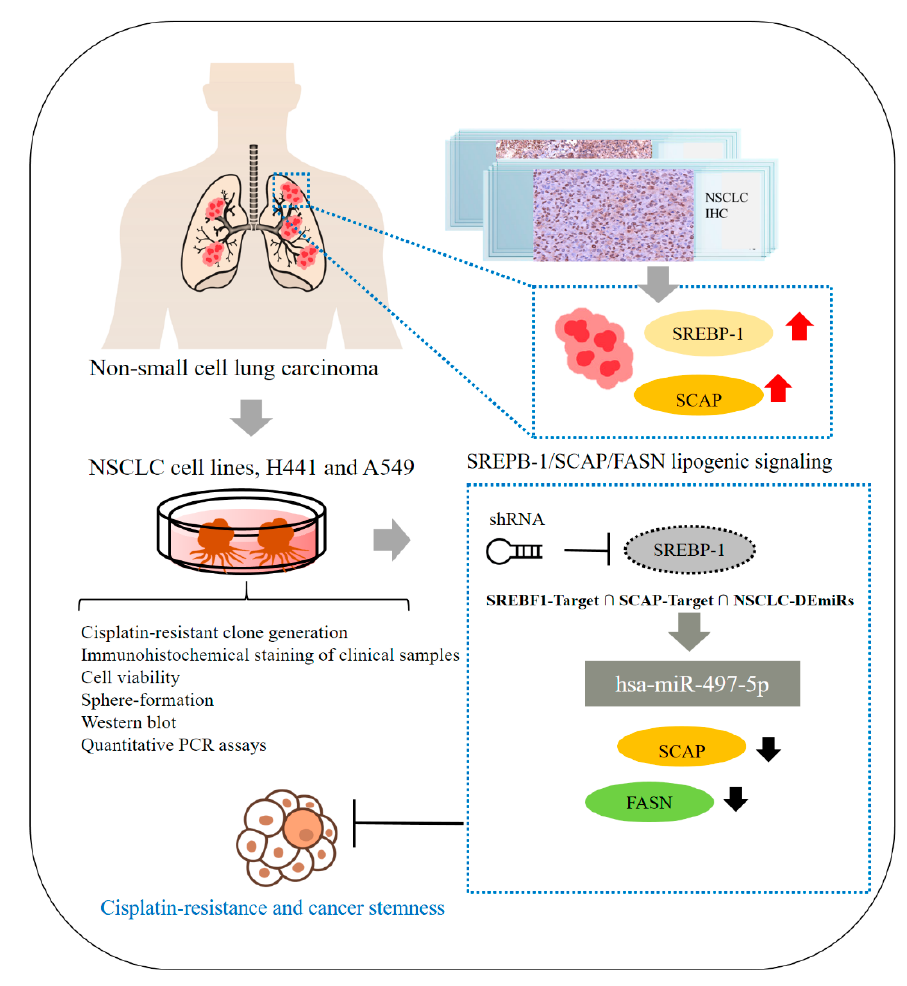
Figure 7. Schematic abstract showing that the role of SREBP-1/hsa-miR-497-5p/SCAP/FASN lipogenic signaling plays a critical role in NSCLC SC-like and chemo-resistant phenotype.